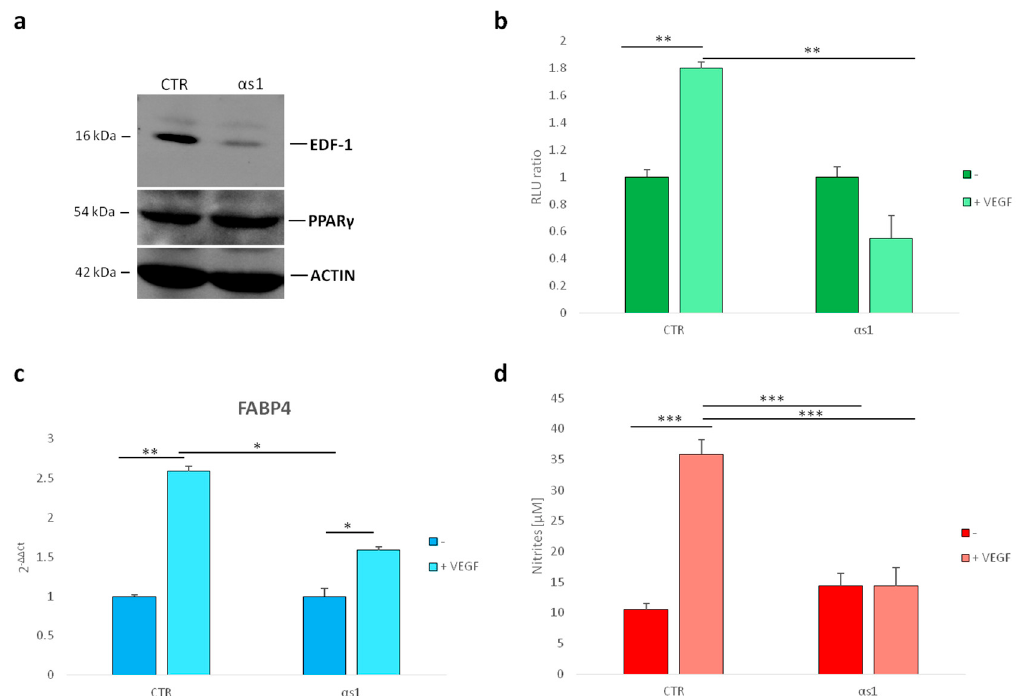
Figure 4. PPAR γ transcriptional activity in HUVEC with silenced EDF1. ( a ) The modulation of PPAR γ was evaluated in α s1 cells ( α s1) (HUVEC with stably silenced EDF1) and compared to HUVEC transfected with a scrambled nonsilencing sequence (used as control) (CTR). Cell lysates were analyzed by western blot using antibodies against EDF1, PPAR γ , and actin. A representative blot is shown; ( b ) PPAR γ activity was evaluated by luciferase assay in α s1 cells and compared to the control HUVEC; ( c ) Real-Time PCR was performed on RNA samples from α s1 cells and relative control, treated or not with VEGF (50/ng/mL) for 24 h. Three different experiments in triplicate were performed; ( d ) Nitric oxide (NO) release was measured using the Griess method for nitrate quantification. The values were expressed as the mean of three different experiments in triplicate ± standard deviation. * p < 0.05, ** p < 0.01, *** p <